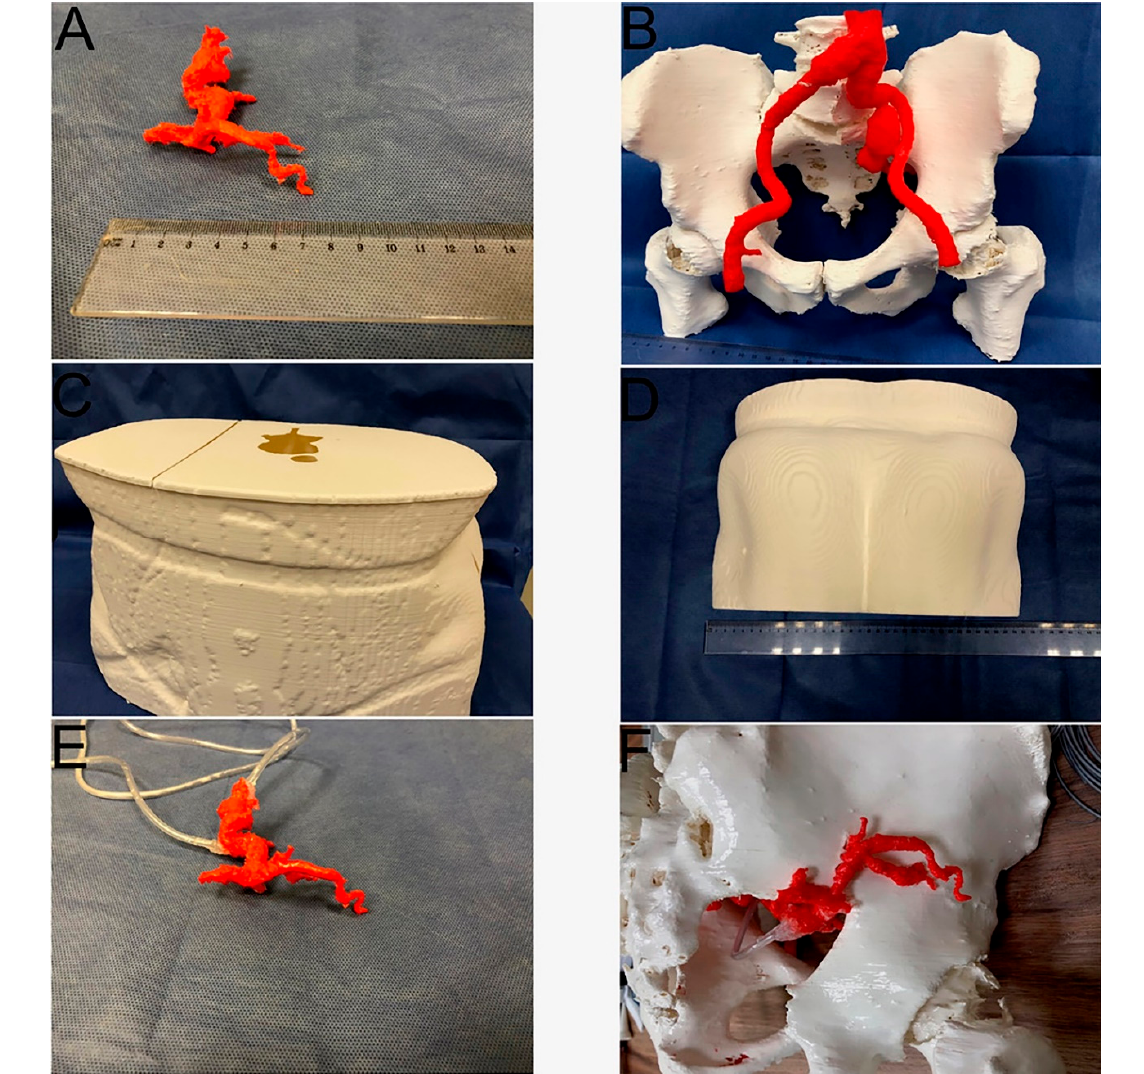
Figure 2. Three-dimensionally printed parts and their assembly. ( A ) Gluteal artery and internal iliac artery aneurysm lumen ( B ) Bones and arterial system ( C ) Skin shell, front and upper part with openings visible; ( D ) Skin shell, rear part ( E ) Gluteal artery model with outlet and inlet ducts ( F ) Gluteal artery model glued to the pelvic bone model.